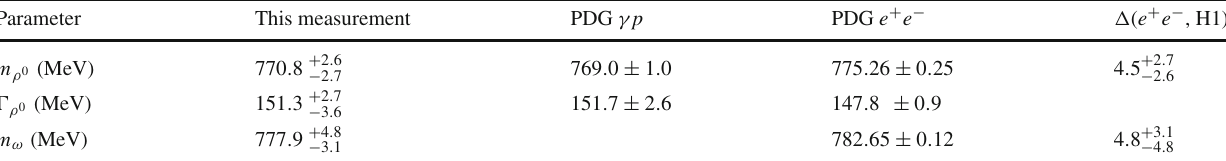
Table 6 Comparison of measured ρ 0 and ω meson properties to the PDG values [33]. Only the total uncertainties are given. The last column gives the mass differences between the PDG e + e − and the present measurement